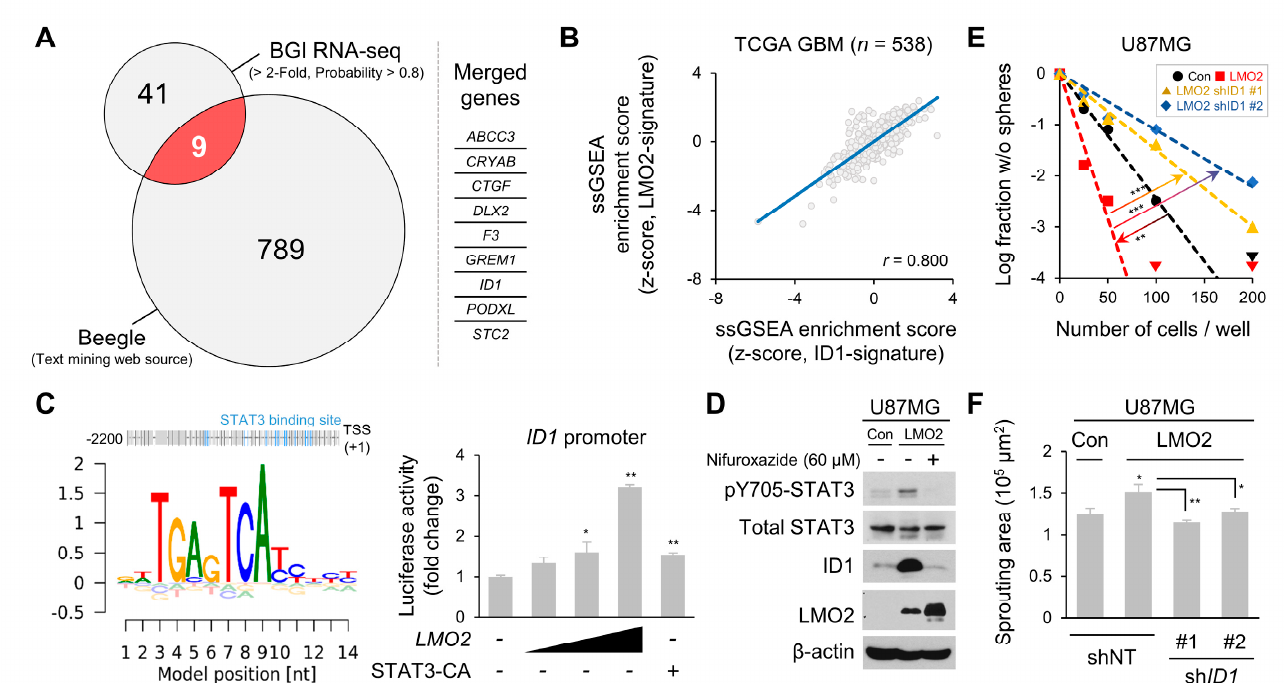
Figure 4. ID1, which is Elevated by LMO2-STAT3 Axis, Regulates Glioma Stem Cell (GSC) Proper- ties. ( A ) Venn diagram showing overlapping genes between the 2-fold upregulated genes identified in the U87MG-LMO2 and glioblastoma-related genes searched by literature-based mining tool, Bee- gle [28] (https://beegle.esat.kuleuven.be/; search term: “glioblastoma”, accessed on 13 October 2019). Red: Merged genes. ( B ) Single-sample gene set enrichment analysis (ssGSEA) showed a positive